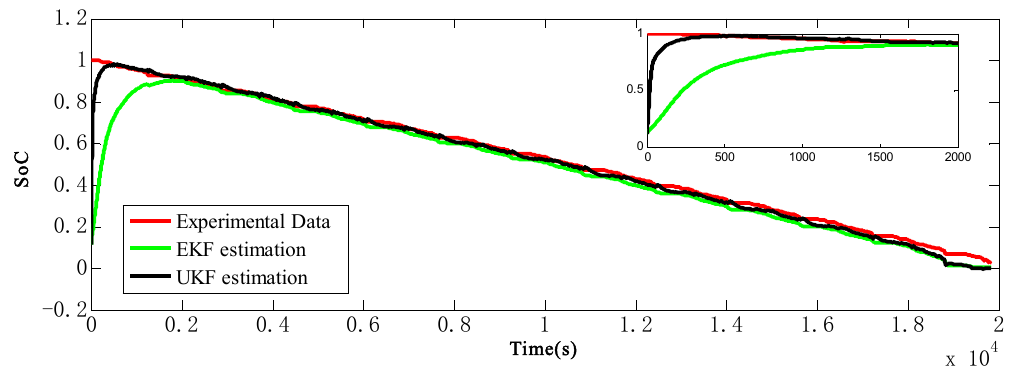
Figure 14. SoC estimation curves with 0.1 of initial